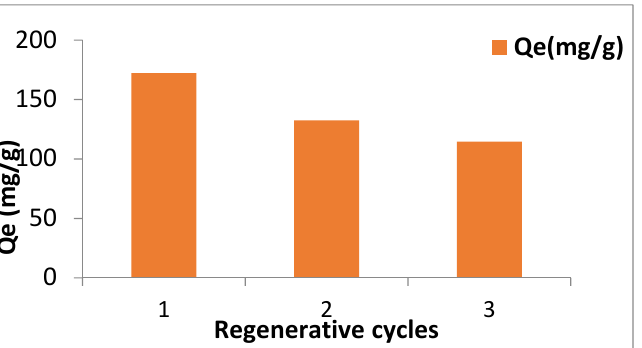
Figure 11. Effect on adsorption capacity of the prepared nanomaterial after regenerative cycles.